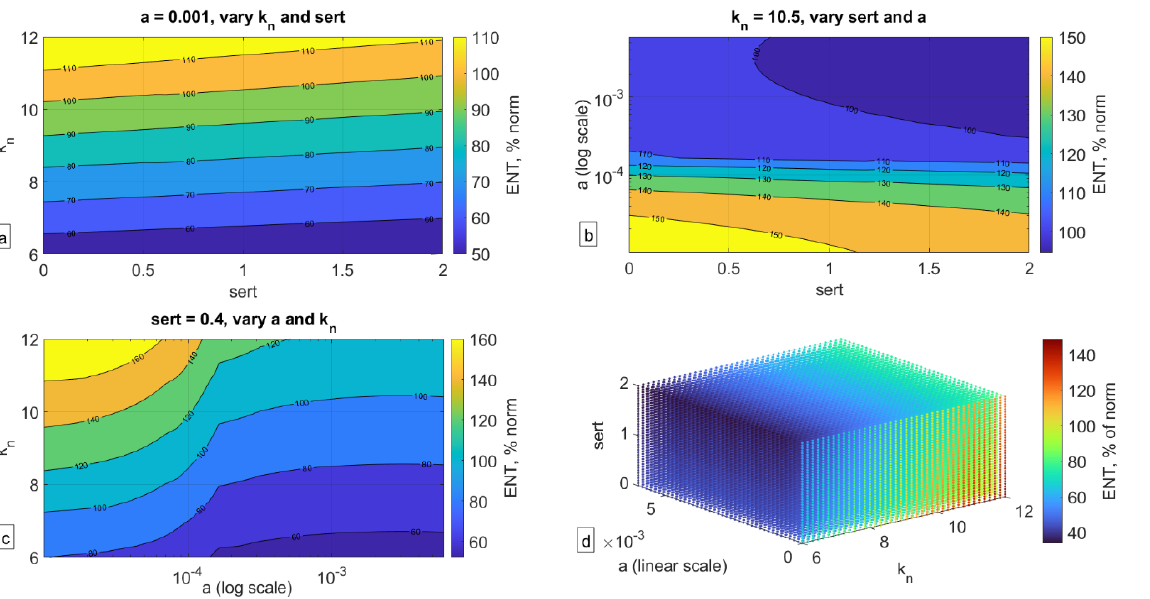
Figure 4. Model-based assessment of the impact of varying the three main factors that functionally connect levels of serotonin in the gut and ENS size. Solid blue line represents the norm ( k n = 10.1; sert = 0.4; a = 0.0006); dot-dashed red and dashed green lines represent the impact of deviation of the norm. ( a ) The rate of serotonin clearance ( sert = 0.4) and rate ENS growth as a function of serotonin concentration ( k n = 10.1) are fixed; rate of serotonin production over time a is varied. ( b ) Rate of serotonin production over time (parameter a ) and serotonin-mediated ENS growth ( k n ) are fixed; rate of SERT-mediated serotonin clearance from the gut is varied. ( c ) Varying rate of serotonin-mediated ENS growth ( k n ), while keeping the other two factors fixed.